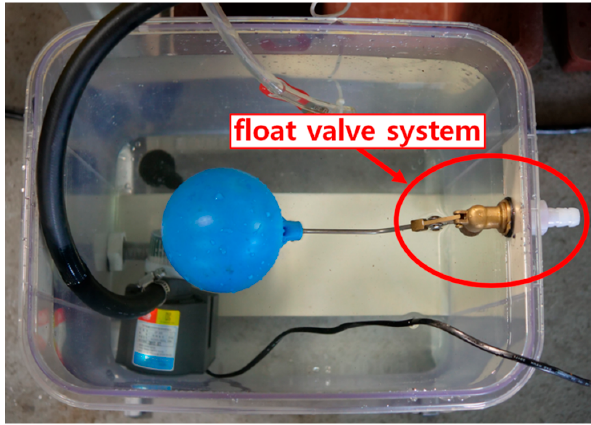
Figure 3. Picture of the water tank. Table 2. Specifications of the water pump.